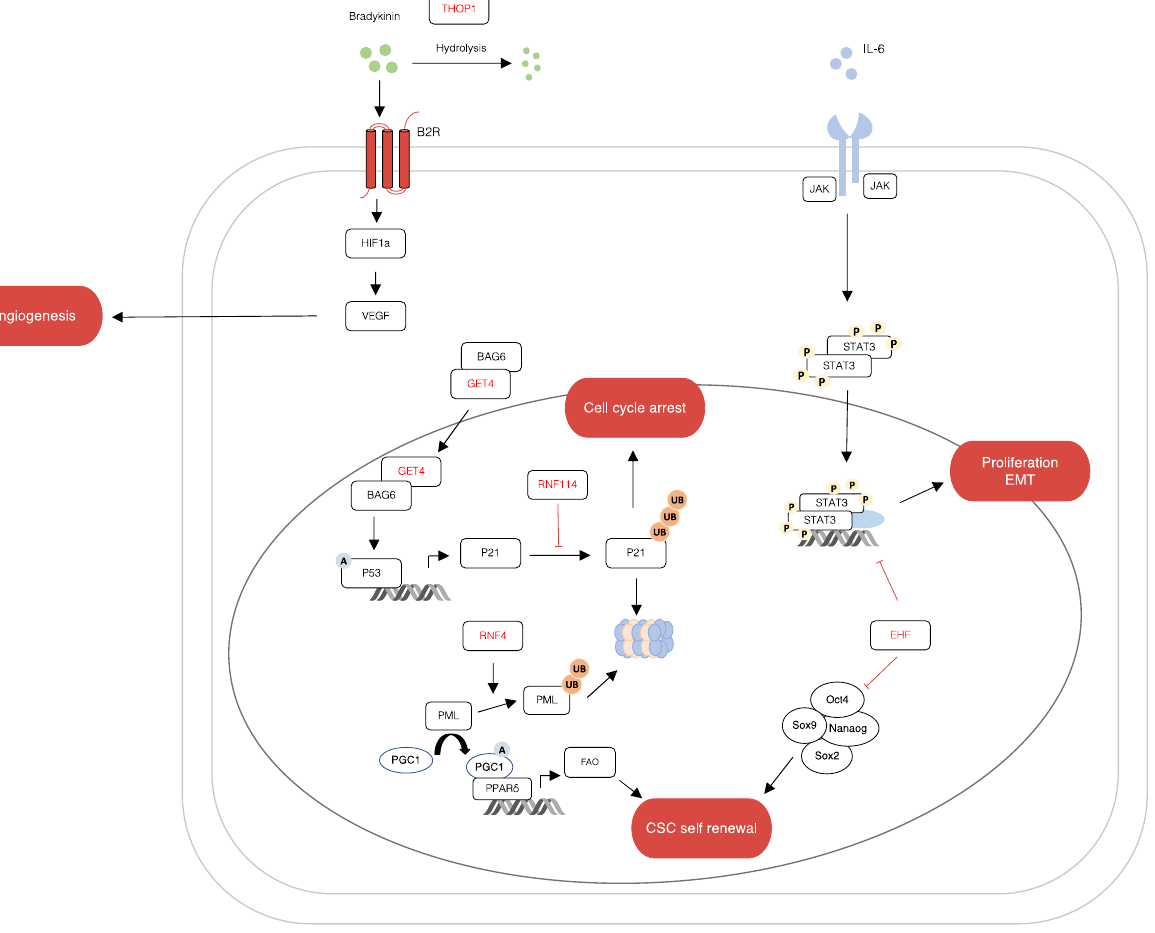
Figure 6. miR-1307 can regulate genes involved in OSCC progression. The figure shows a schematic representation of the relationships between putative genes targeted by miR-1307. Many of these genes modulate important cellular processes like cell proliferation, apoptosis, angiogenesis and maintenance of cancer stem